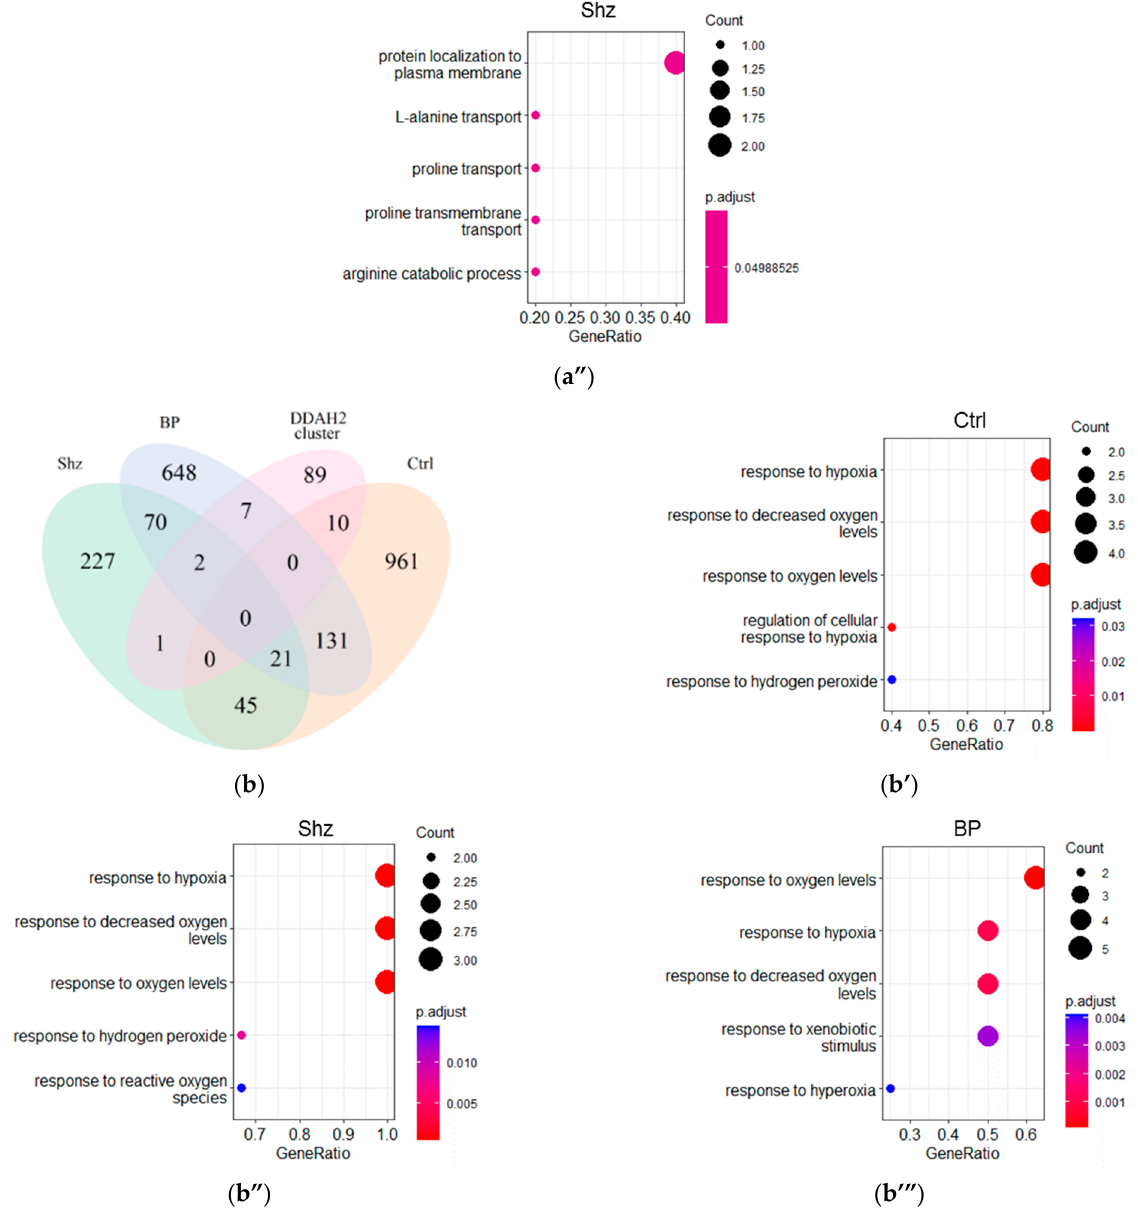
Figure 2. Expression of DDAH1 ( a ) and DDAH2 ( b ) interacting genes in the study groups. Venn diagram illustrating an overlay of genes co-expressed (r > 0.3, p > 0.05) with DDAH1 or DDAH2 in non-psychiatric controls (Ctrl), patients with bipolar disorder (BP), and schizophrenia (Shz) and the sets of genes involved in the functional interaction with DDAH1 and DDAH2 according to the public resources’ data. Gene ontology (GO) enrichment analysis of genes involved in the functional interaction with DDAH1 and DDAH2 according to the public resources’ data, which are co-expressed with DDAH1, top five of enriched GO groups are represented in controls ( a’ ), patients with schizophrenia ( a” ), and DDAH2 in the controls ( b’ ), patients with schizophrenia ( b” ), and patients with bipolar disorder ( b’” ). GO biological process terms showed no appropriate terms enrichment in the DDAH1 co-expressed gene cluster in patients with bipolar disorder.